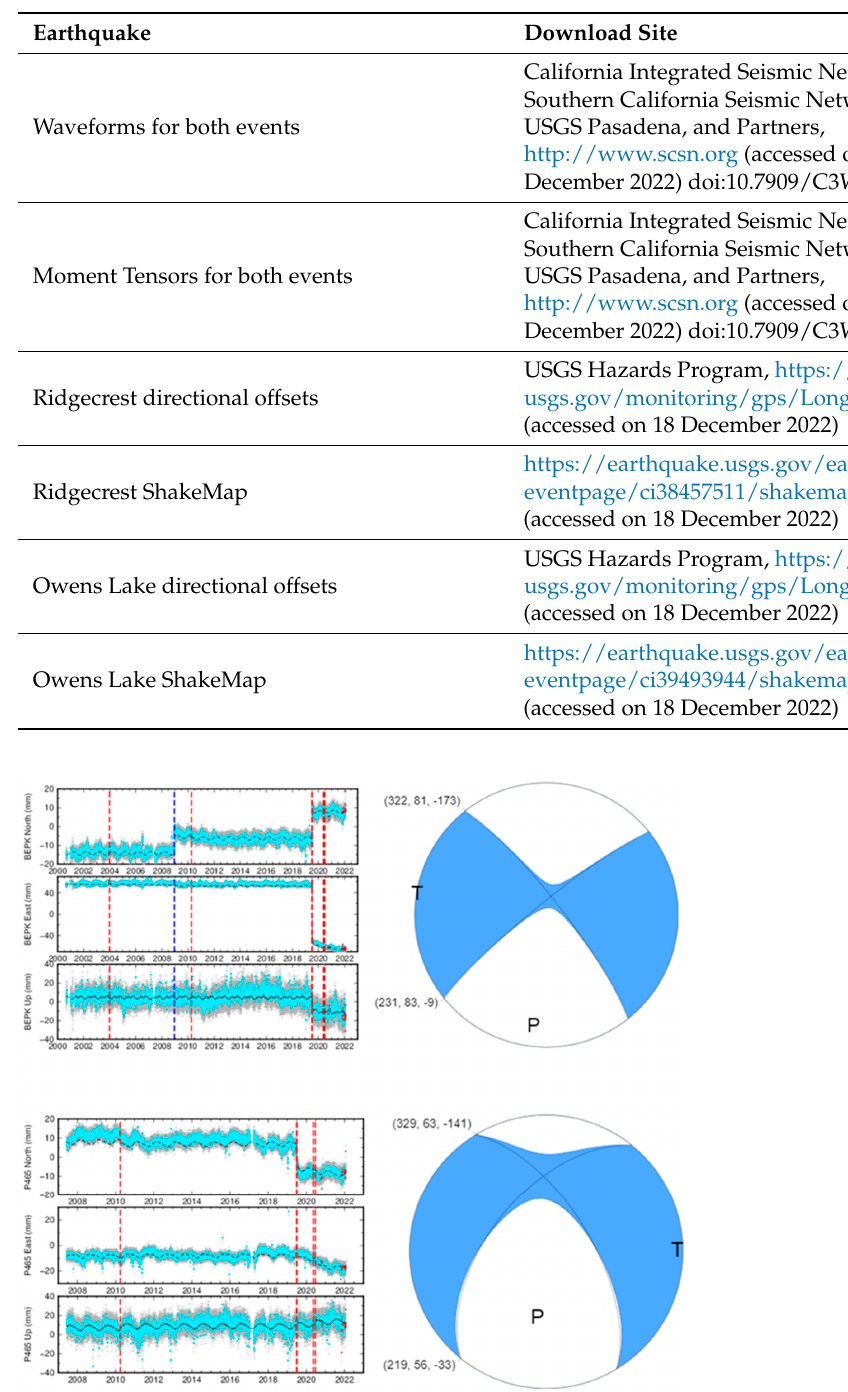
Table 2. Data sources for the Ridgecrest and Owens Lake earthquake events.